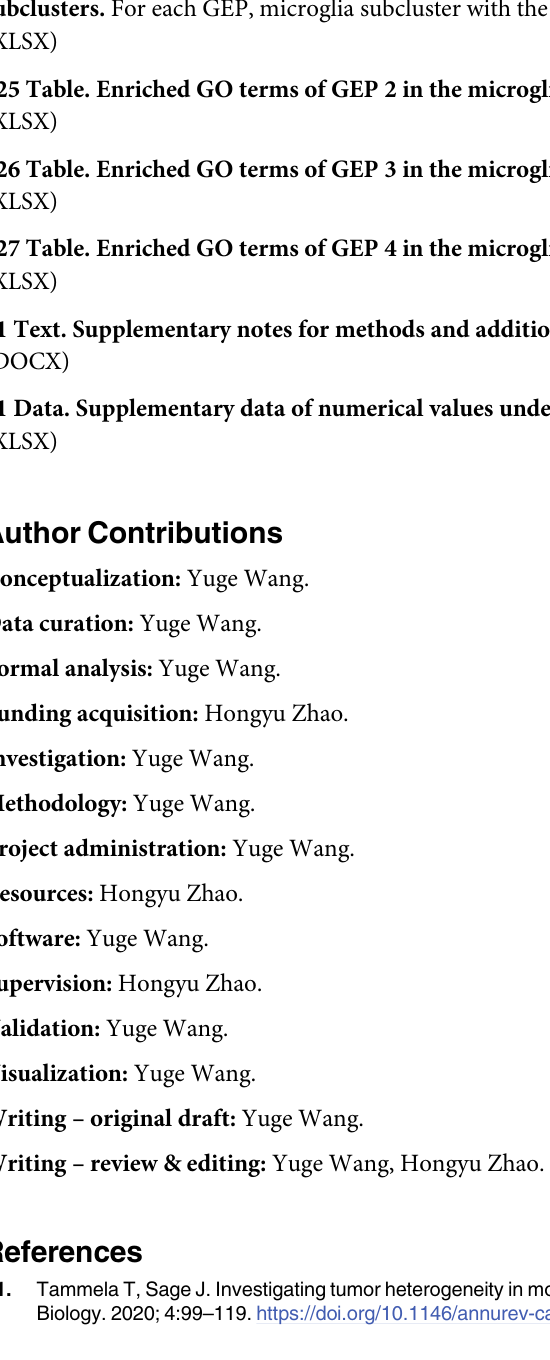
S22 Table. Upregulated DEGs (adjusted p-value < 0.05) of GEP 3 in the microglia of the prefrontal cortex dataset. S23 Table. Upregulated DEGs (adjusted p-value < 0.05) of GEP 4 in the microglia of the prefrontal cortex dataset. S24 Table. Enrichment of GEP-specific DEGs across sets of makers of the four microglia subclusters. For each GEP, microglia subcluster with the lowest p-value is highlighted in